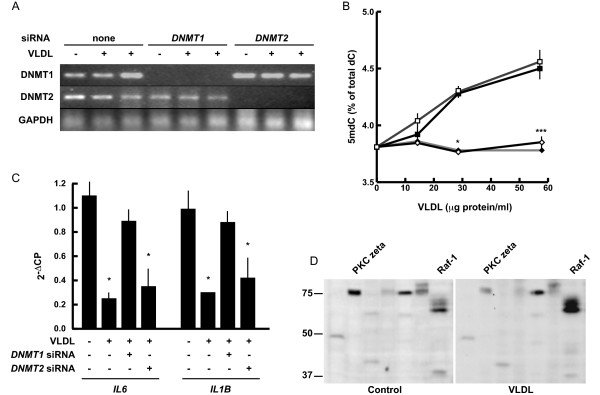
DNMT1 mediates VLDL-induced de novo DNA methylation. A, RT-PCR analysis of DNMT expression in siRNA-treated cells stimulated with two preparations of VLDL at 58 μg protein/ml. B, effects of siRNA-mediated knockdown of DNMT1 or DNMT2 on total 5 mdC content. Solid squares, control; open squares, DNMT2-specific siRNA; solid diamonds, DNMT1-specific siRNA ID no. 110915; open diamonds, DNMT1-specific siRNA ID no. 110917 (both from Ambion). Asterisks indicate statistically significant comparisons between siRNA-treated and control cells. For simplicity, when cells treated with either DNMT1-specific siRNA show different significance levels, only the lower one is shown (*, P < 0.05; ***, P < 0.001). C, effects of siRNA treatment on the methylation status of IL6 and IL1B, as assessed by COBRA. DNAs from the two DNMT1-specific siRNAs were pooled for this analysis. Statistical significance is indicated as in B. Bars, standard deviations. D, VLR alters baseline phosphorylation of PKC zeta and Raf-1. Fields of Kinexus Kinetworks™ Phospho Site Screen KPSS-4.1 containing PKC zeta T410 and Raf-1 S259 in control and VLR-stimulated cells. Raf-1 migrates as multiple bands reflecting multiple phosphorylation states [55]. Positions of relevant MW standard are shown on the left (kDa).